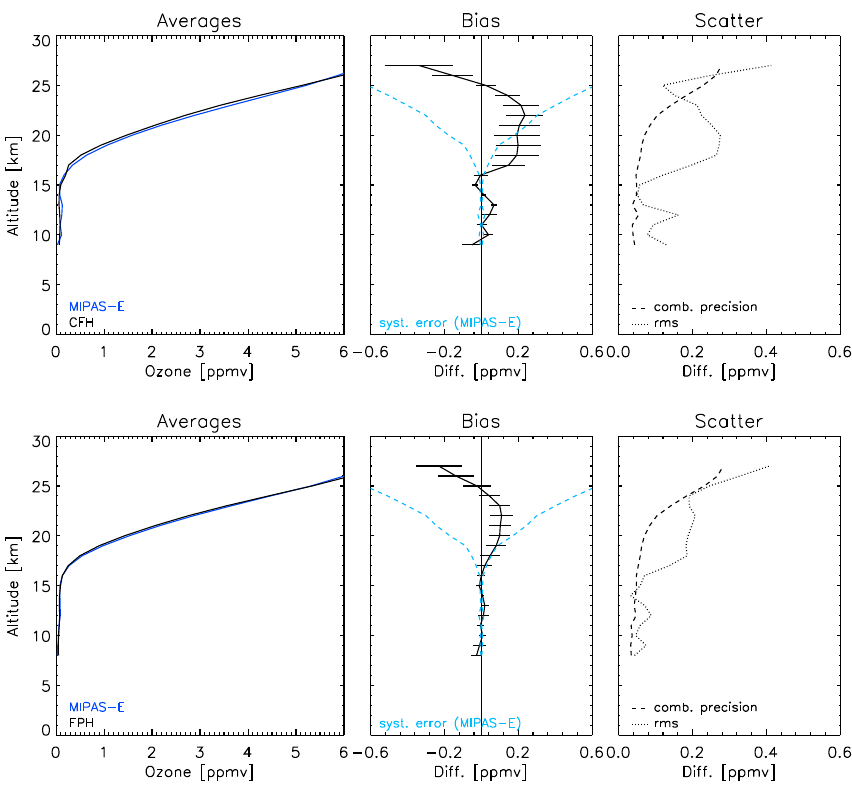
Fig. 17. Same as Fig. 2, but for ozonesonde profiles recorded on flights with the CFH v3.20 (top row) and NOAA FPH (bottom row) frost point hygrometers. For a more detailed description see Fig. 2.